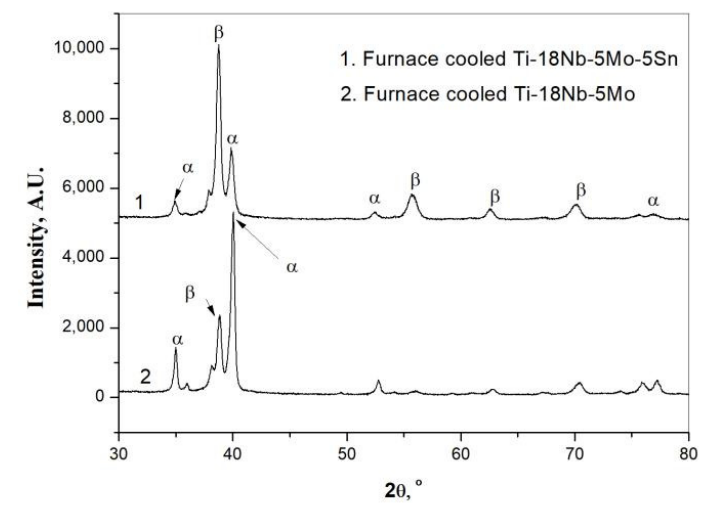
Figure 3. X-ray diffraction profiles of the furnace-cooled Ti-18Nb-5Mo and Ti-18Nb-5Mo-5Sn alloys.